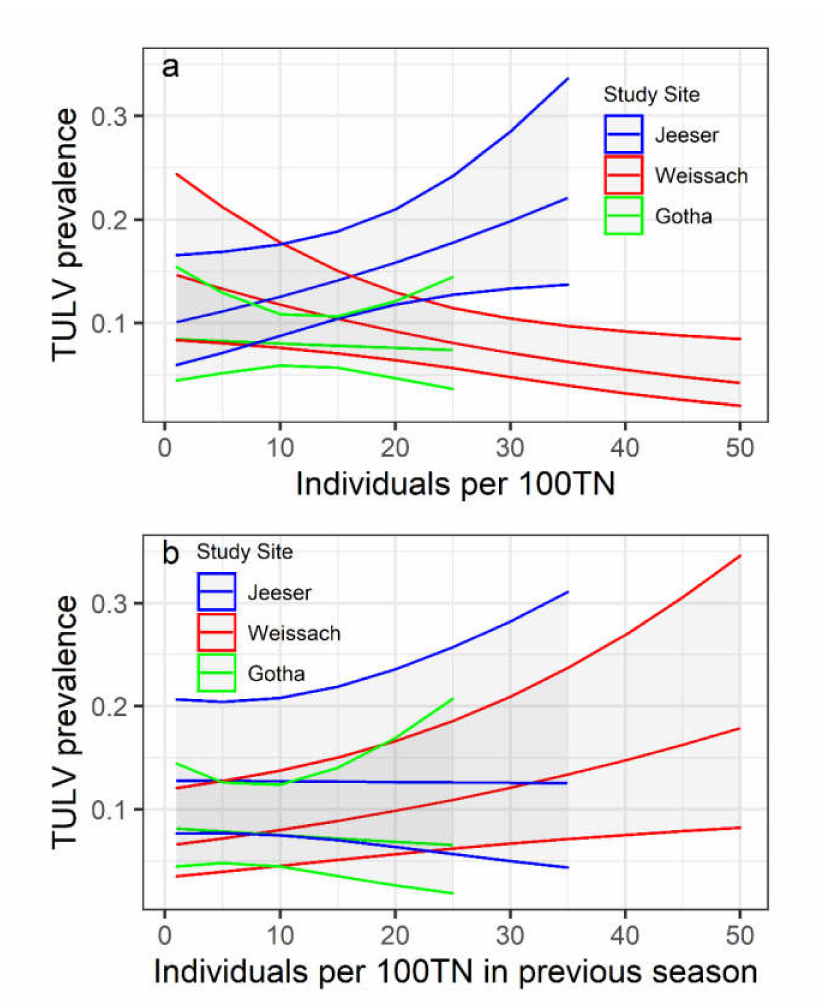
Figure 3. ( a ) Direct and ( b ) delayed effects of common vole abundance (as index with individuals per 100 trap nights) per study area on TULV seroprevalence in the host